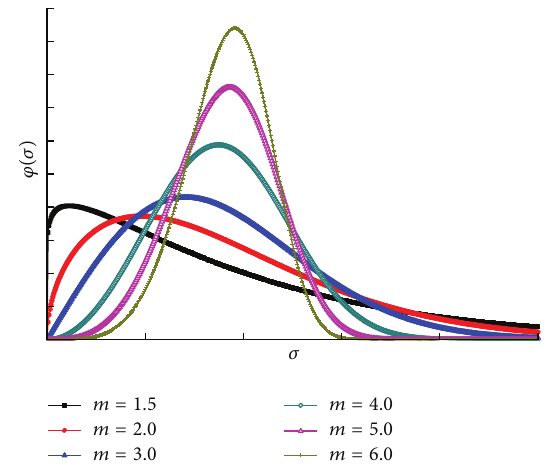
Figure 1: Weibull distribution for mechanical properties of rock materials with different homogeneity indices 𝑚